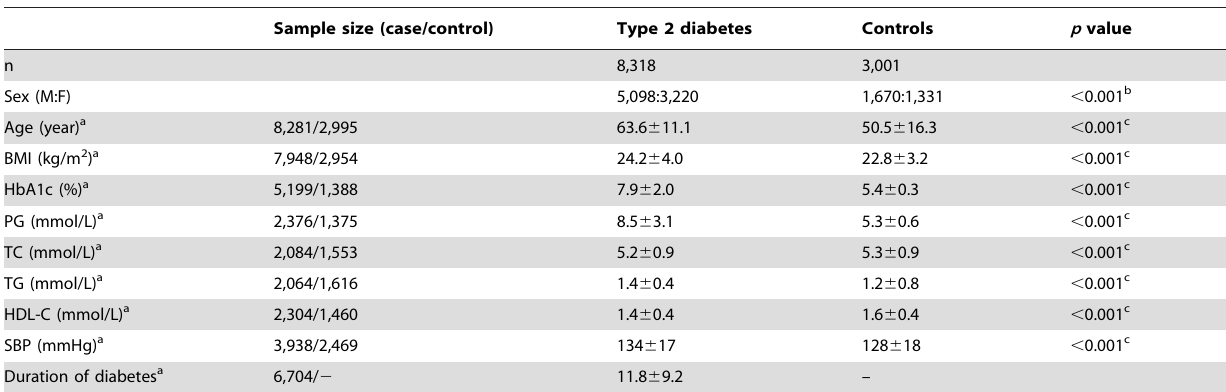
Table 1. Characteristics of